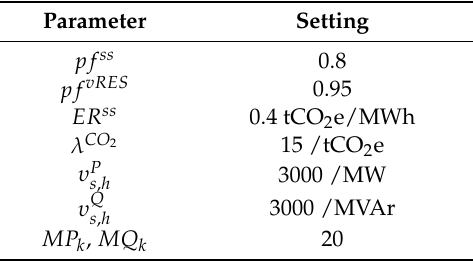
Table 3. Further data-related assumptions.